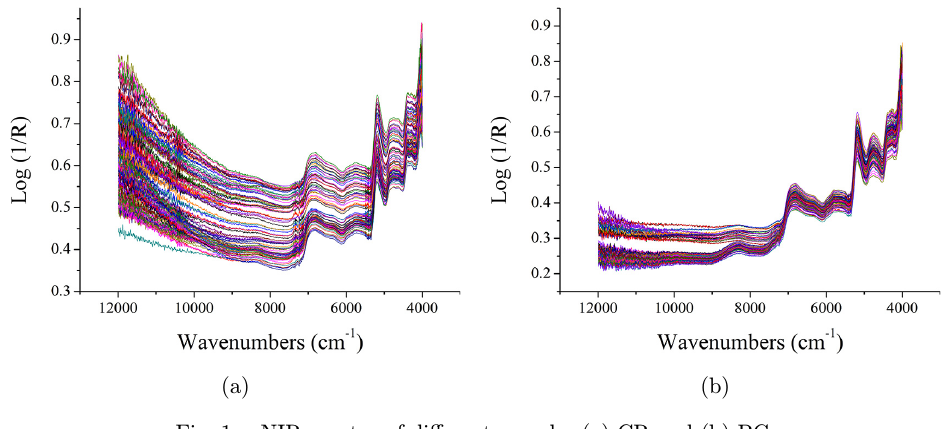
Fig. 1. NIR spectra of di®erent samples (a) CR and (b) PC. Table 1. Reference data by legal